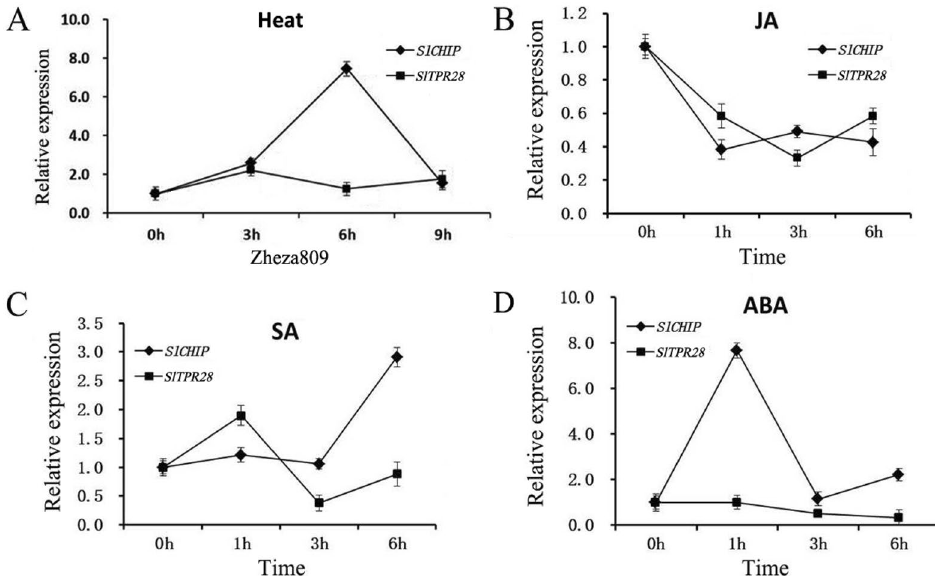
Figure 3. Expression of SlCHIP and SlTPR28 in response to heat, SA, JA and ABA. Six-week-old tomato plants were treated at 45 °C ( A ) or sprayed with 100 μM MeJA ( B ), 20 μM SA ( C ) and 20 μM ABA ( D ) for the indicated amounts of time. At least 3 leaflets of the fourth leaves from 3 individual plants for each sample were collected at 0-, 3-, 6-, and 9-h after treatment for RNA isolation and RT-qPCR analysis. Error bars indicate SE (n = 3). The experiments were repeated three times with similar